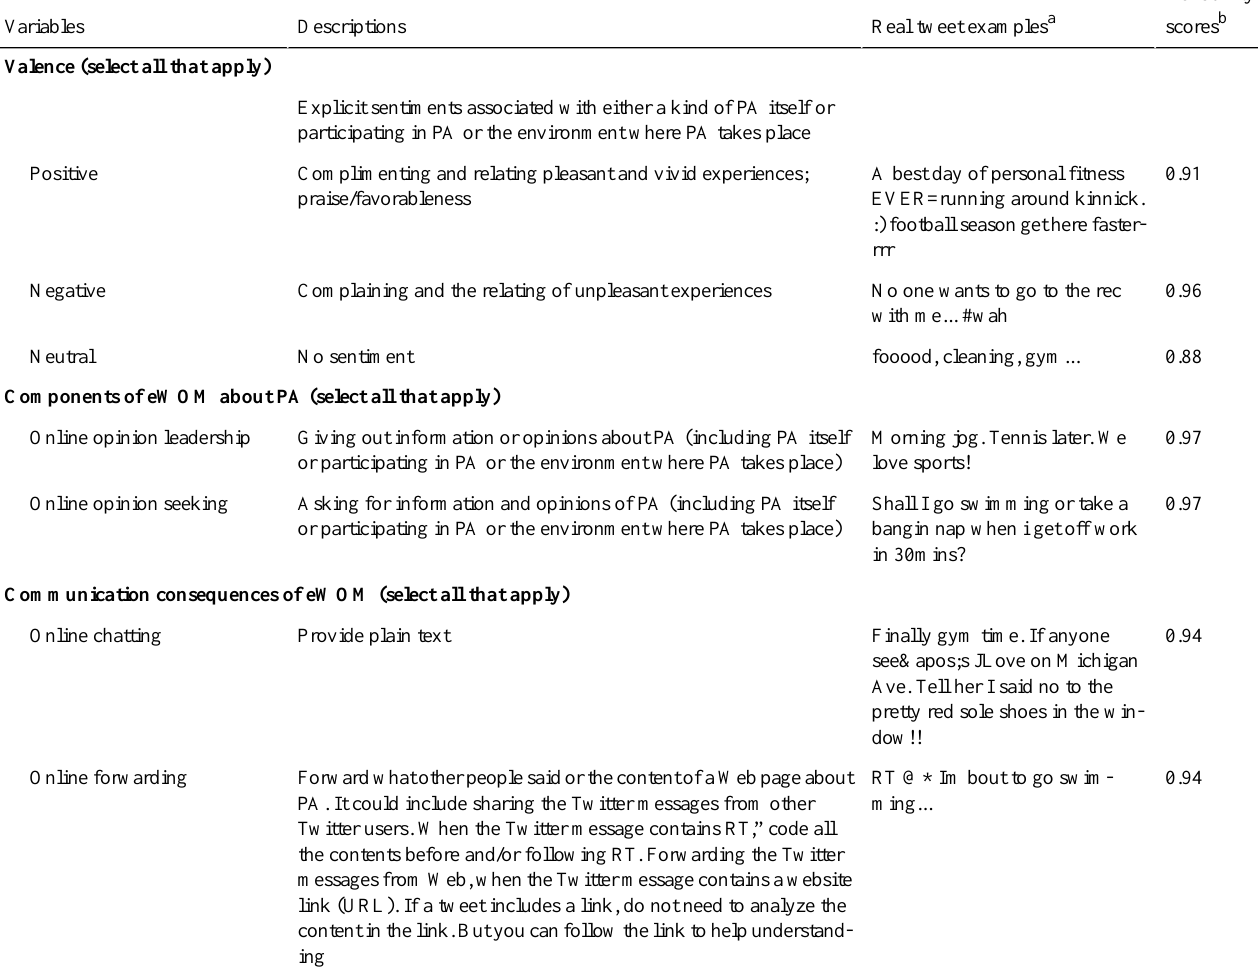
Table 1. Coding scheme and intercoder reliability scores of tweets about physical activity (PA).